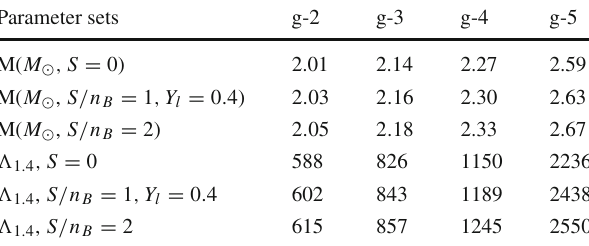
Table 1 The maximum mass and the corresponding tidal deformability (cid:3) 1 . 4 of QSs and PQSs within quasiparticle model with g-2, g-3, g-4, and g-5